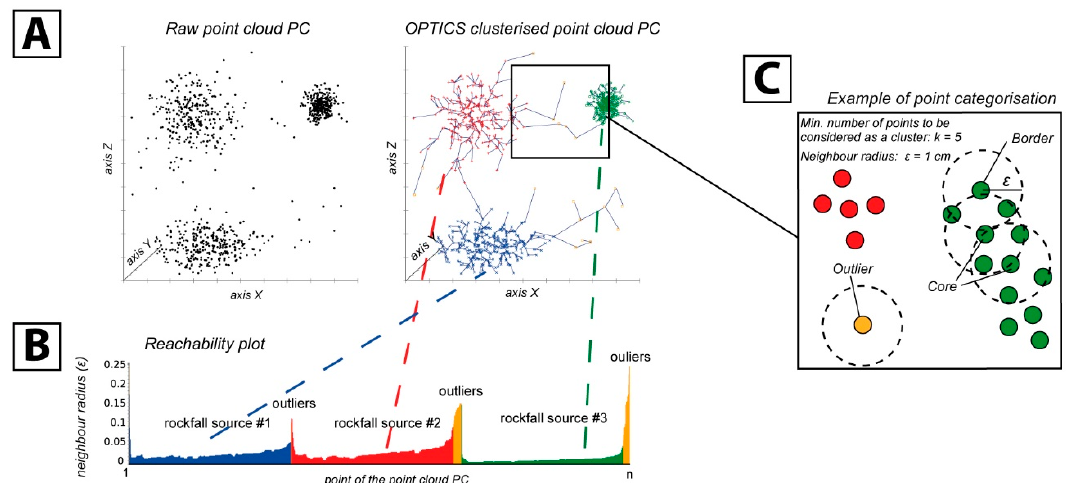
Figure 2 . ( A ) Example of the raw dataset required to individualize the different clusters representing the different rockfall sources. ( B ) The OPTICS (ordering points to identify the clustering structure) density-based clustering algorithm allows classification according to the reachability distance or neighbor radius. ( C ) The classification allows attributing each point as a border or core point. Moreover, the OPTICS algorithm allows the identification of outlier points to remove.